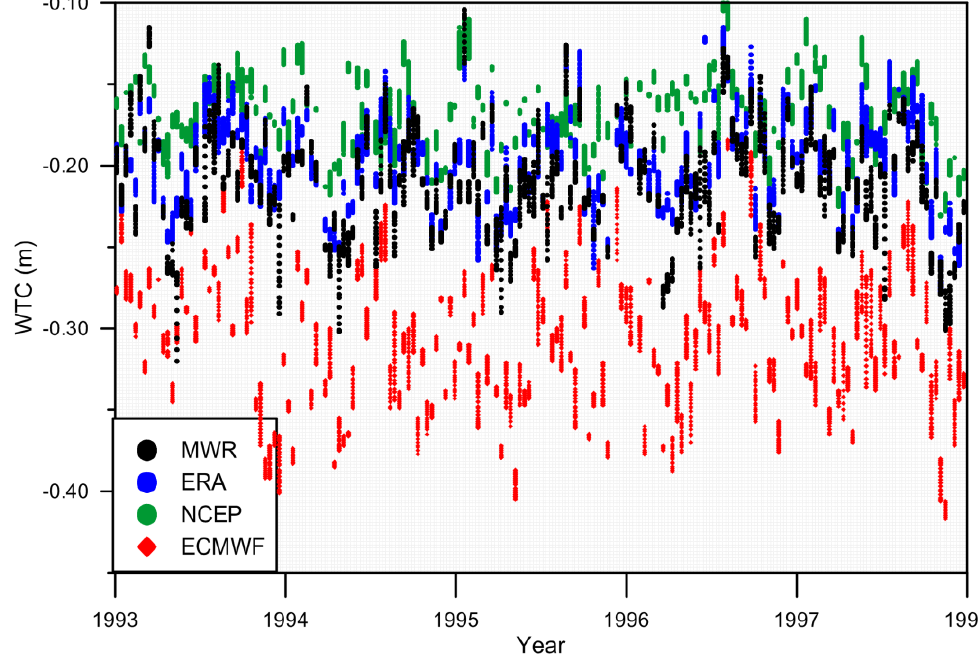
Figure 10. Wet tropospheric correction (WTC) for all T/P measurements over Lake Victoria (Africa) for five years (1993–1998). Only measurements over inland water with valid microwave radiometer (MWR) correction were